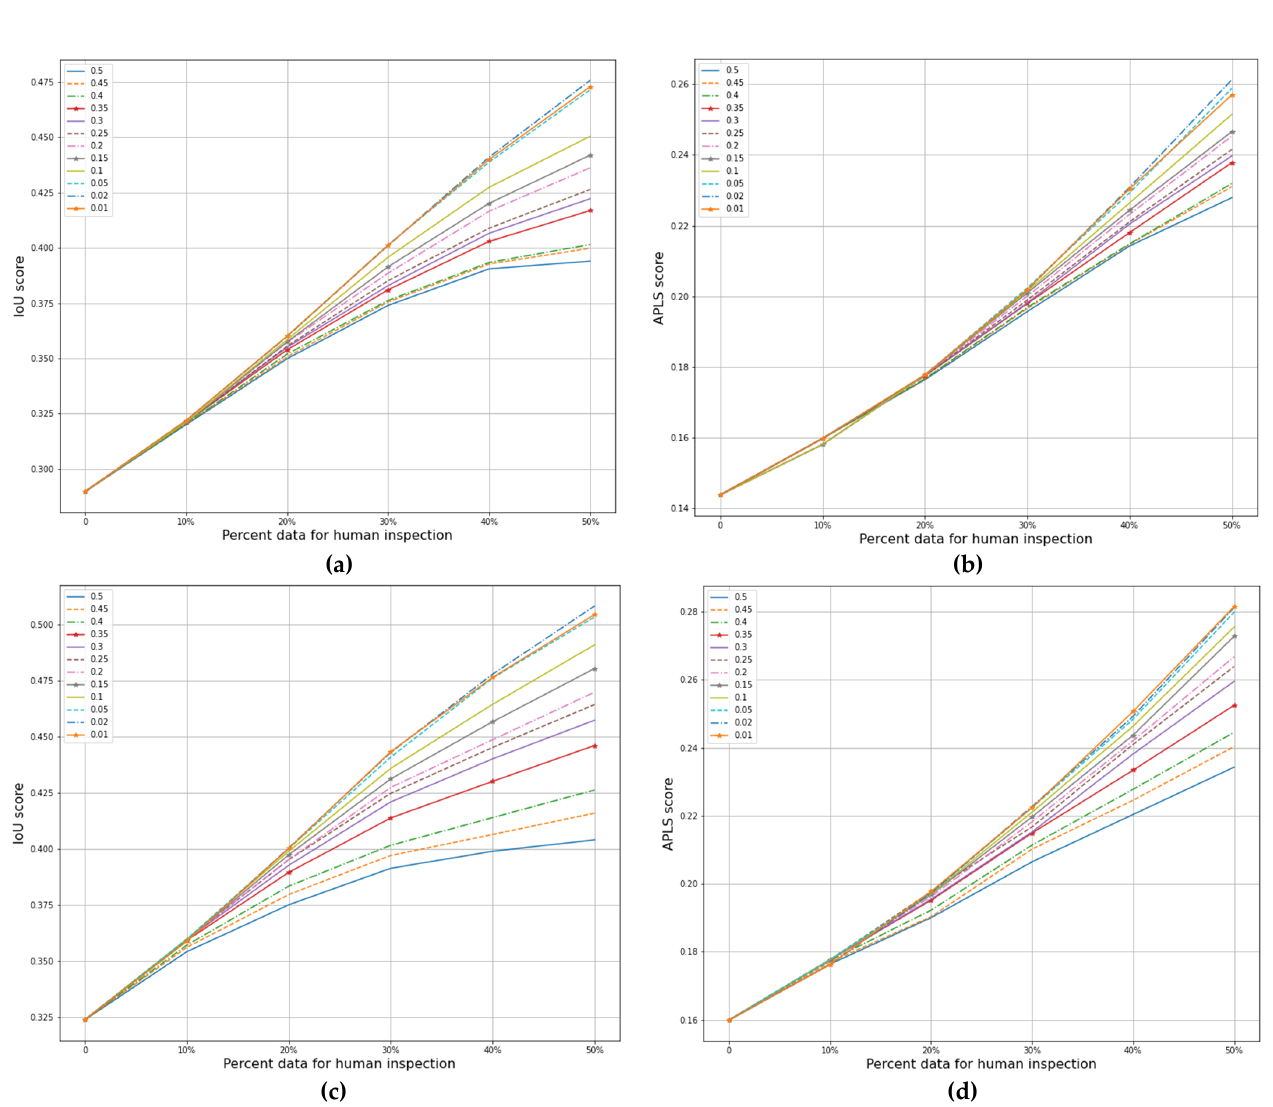
Figure 10. Performance comparison of MCD ( a , b ) and DE ( c , d ) model averages over varying decision thresholds for OOD data. Scores again increase substantially with the OOD test set when using lower road class thresholds, which are displayed for thresholds in the range [0.01,0.5]. This effect increases as more (higher confidence) image chips are sent to humans for quality assurance. The effect is more than twice as large for the DE than for MCD. The effect size for the deterministic model (not pictured) is similar to MCD. The stability of these results across ID and OOD data supports the generalizability of our method. Table 3. Summary of results of model performance in OOD data at varying amounts of thresholding for quality assess- ment.